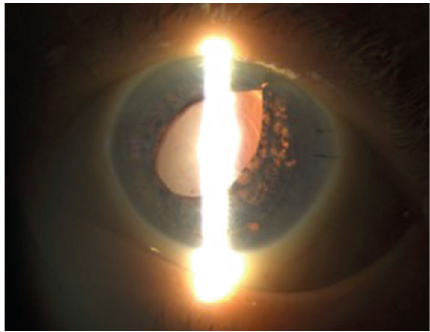
Figure 2: Slit lamp photograph with retroillumination of the left eye one month postoperatively.